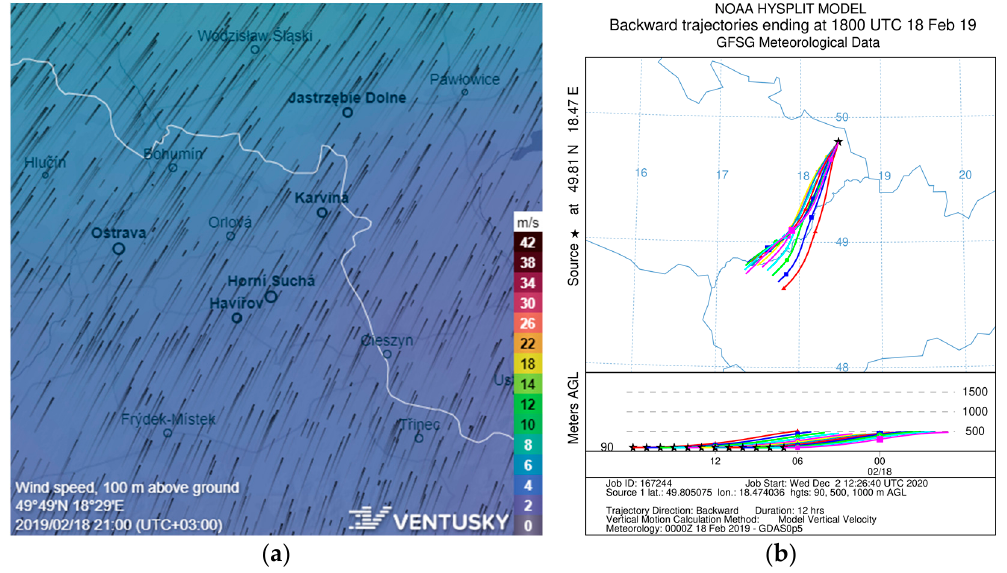
Figure 8. The modelled wind fields ( a ) and backward trajectories ( b ) for February 2019 peak concentrations [48,50,51].